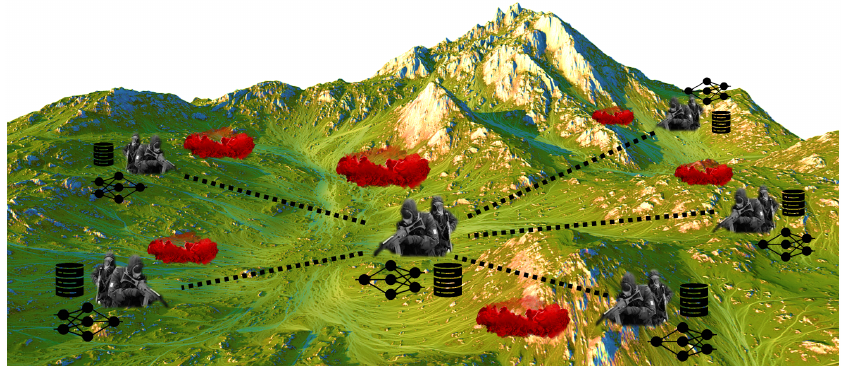
Figure 1. The application concept of the proposed